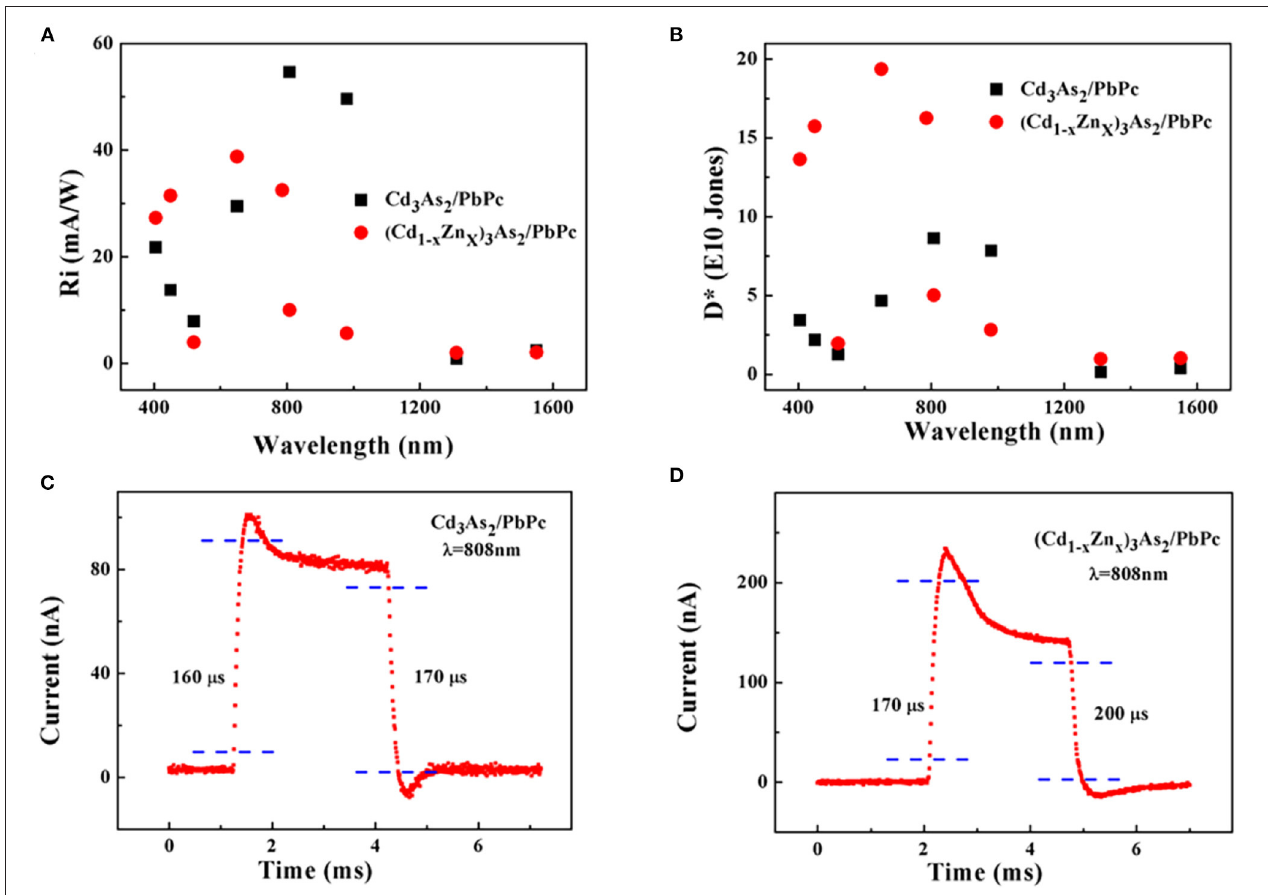
FIGURE 3 | (A,B) The R i and D* curves of DSM/PbPc thin film heterojunction photodetectors under bias voltage mode from 405 to 1,550nm. (C,D) Response time curves of DSM/PbPc thin film heterojunction photodetectors under light illumination (at